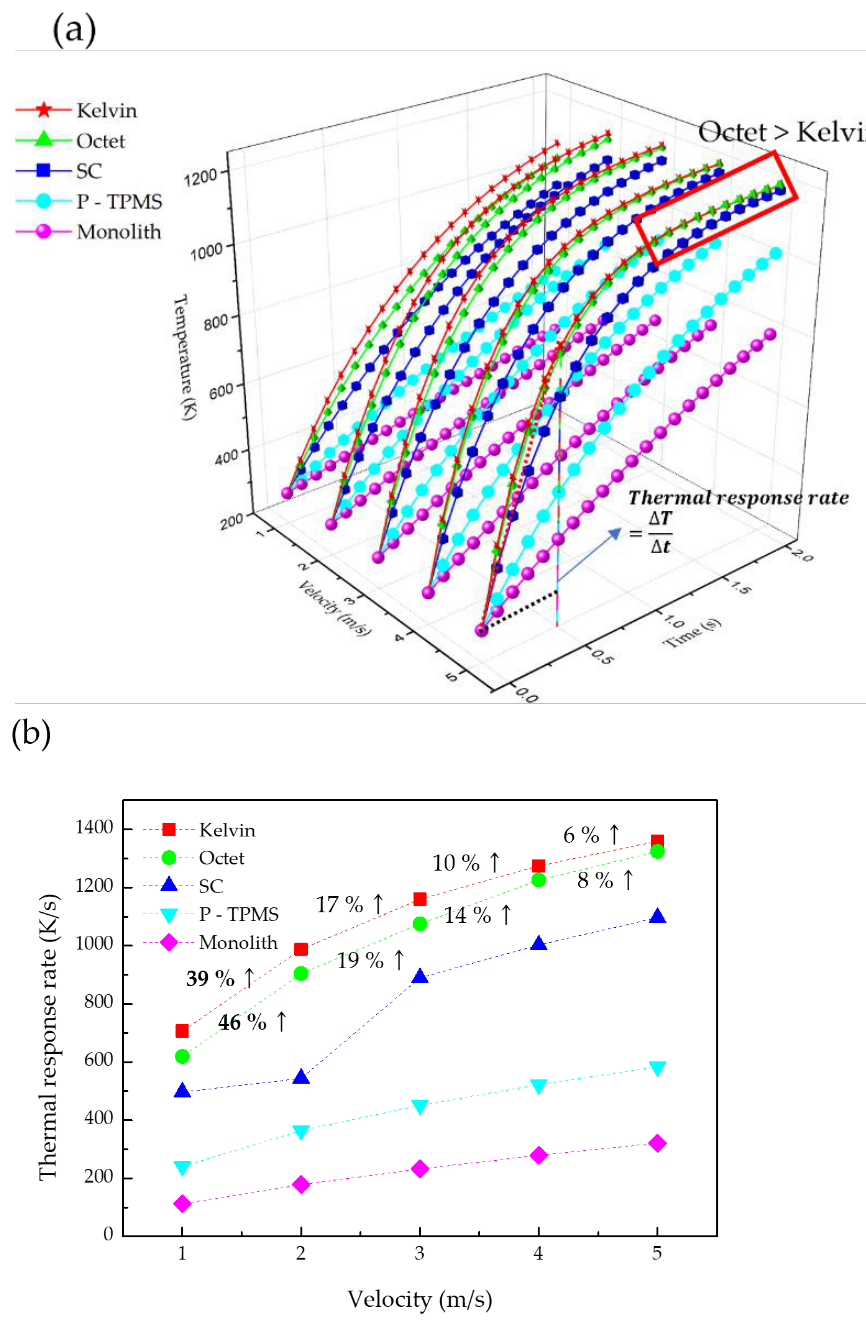
Figure 5. Thermal response comparison for the different 3D microstructures: ( a ) volume-average temperatures as functions of time and velocity; ( b ) thermal response rates as functions of the fluid velocity based on a 0.5 s time frame considering the light-off temperature.